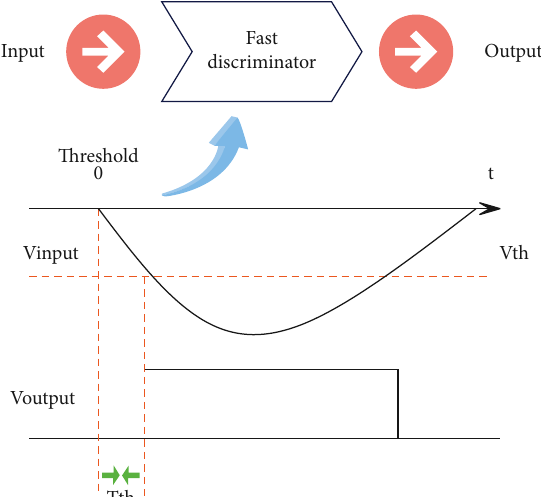
Figure 1: Schematic diagram of leading-edge trigger timing.